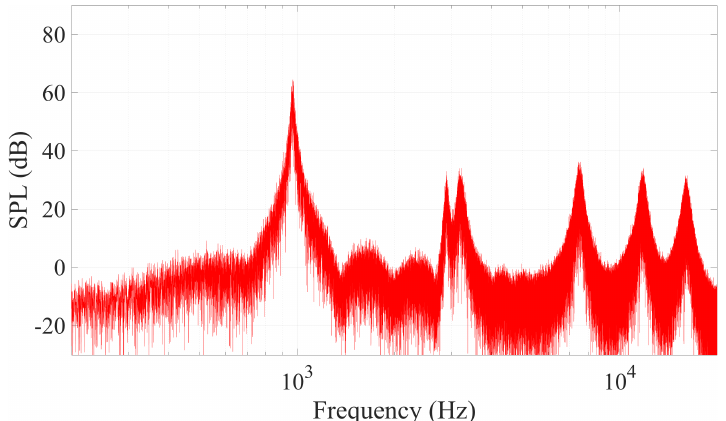
Figure 4. Magnitude spectrum of the physical model of the grooved